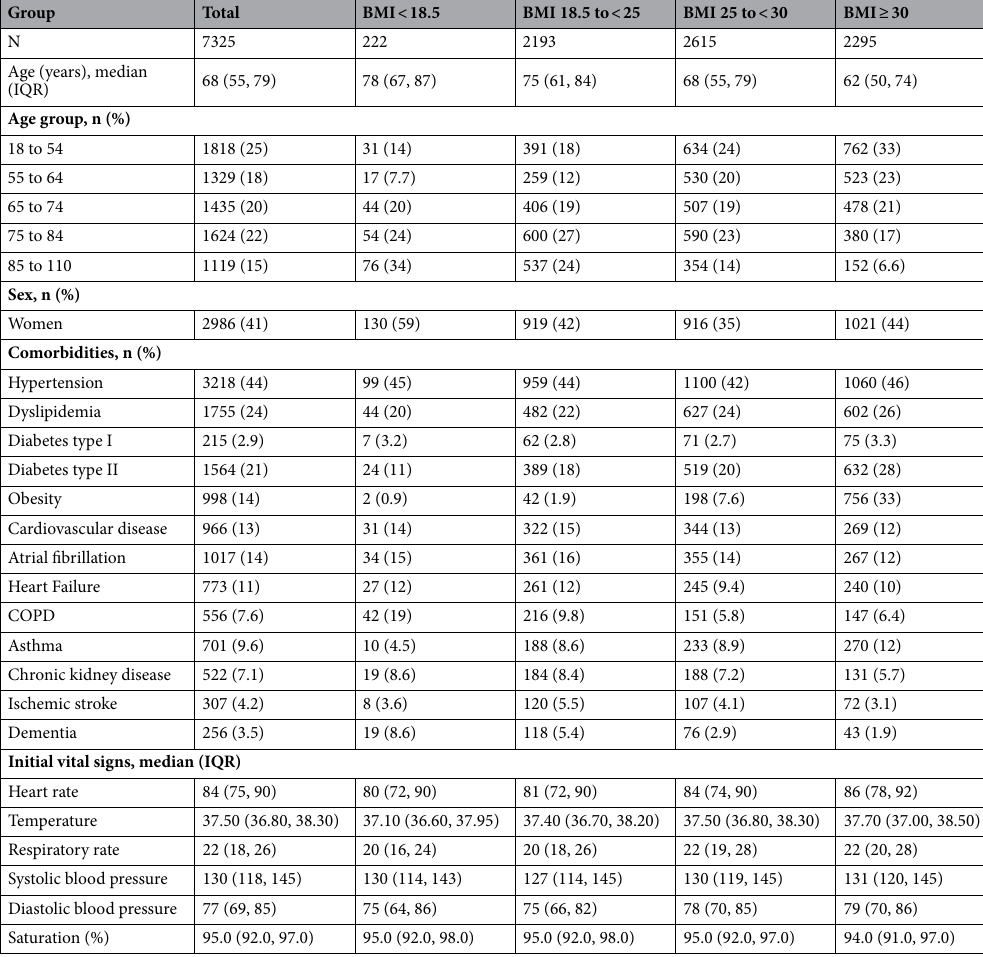
Table 1. Demographic data of study participants by body mass index categories. BMI body mass index, COPD chronic obstructive pulmonary disease, IQR inter quartile